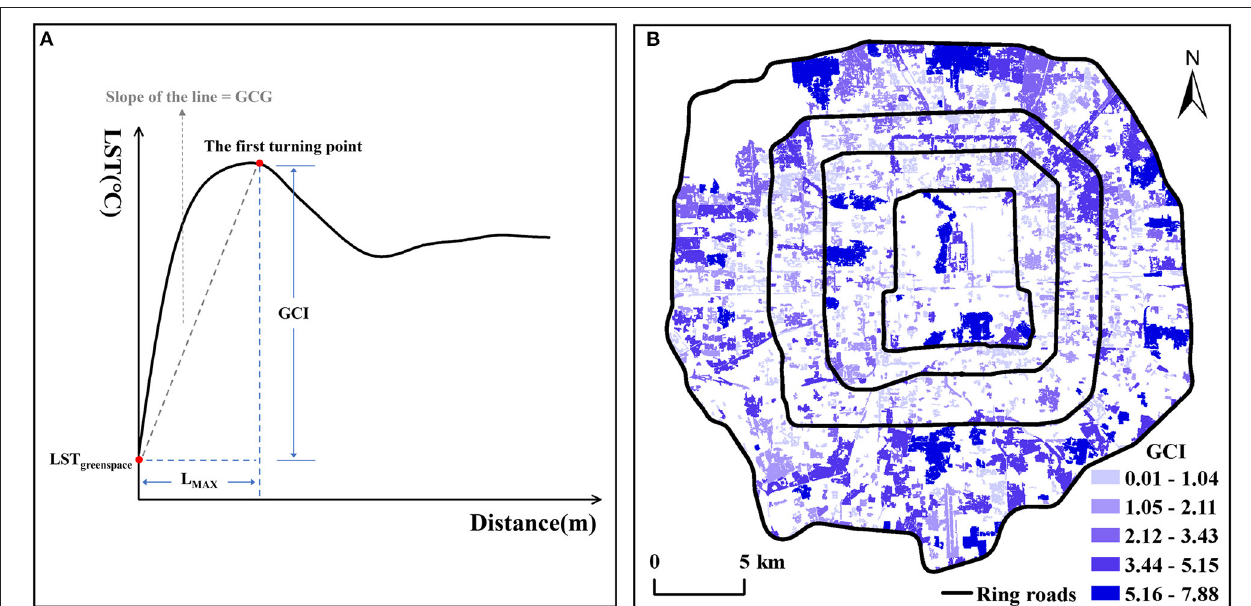
FIGURE 4 | Average LST schematic diagram of green space and surrounding impervious surface (A) , the spatial distribution of 1,157 green spaces with different degrees of GCI (B) .